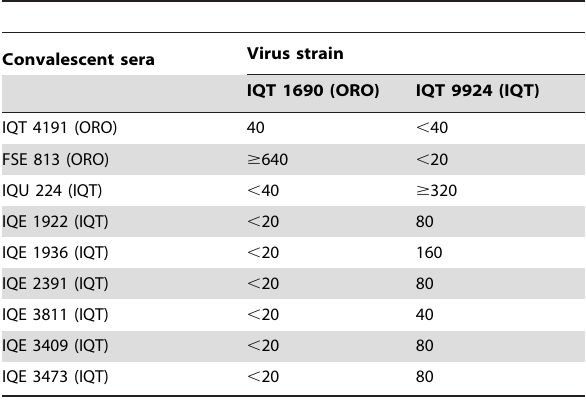
Table 5. Past infection with ORO virus does not protect against disease with IQT9924 (IQT) virus.